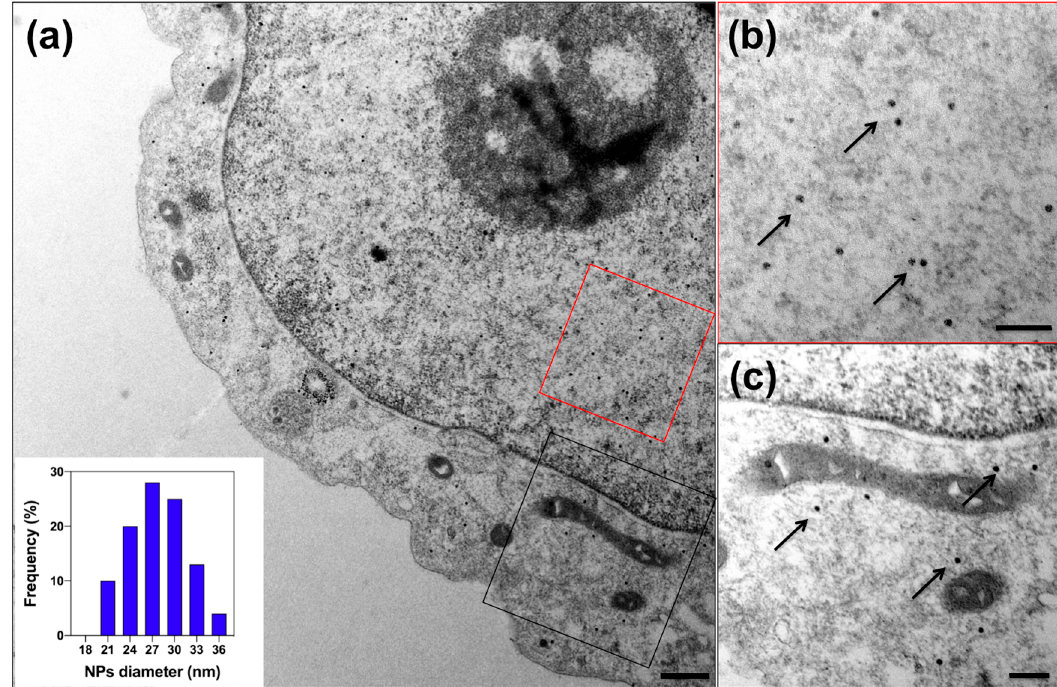
Figure 2. TEM images of the HepG2 cells transiently expressing QtEnc FLAG with QtIMEF cargo protein (QtIMEF P2A QtEnc FLAG ) and iron transporter Zip 14 cultivated in the medium supplemented with 2 mM ferrous ammonium sulfate (FAS) for 24 h. ( a ) Overview TEM image; the scale bar represents 500 nm. Close-up of exemplary regions in the nucleus (( b ), red rectangle) and cytosol (( c ), black rectangle)) with arrows pointing to the individual nanoparticles (NPs) containing iron; the scale bar represents 200 nm. The inset in ( a ) illustrates the size distribution of iron oxide cores inside the encapsulin shells.